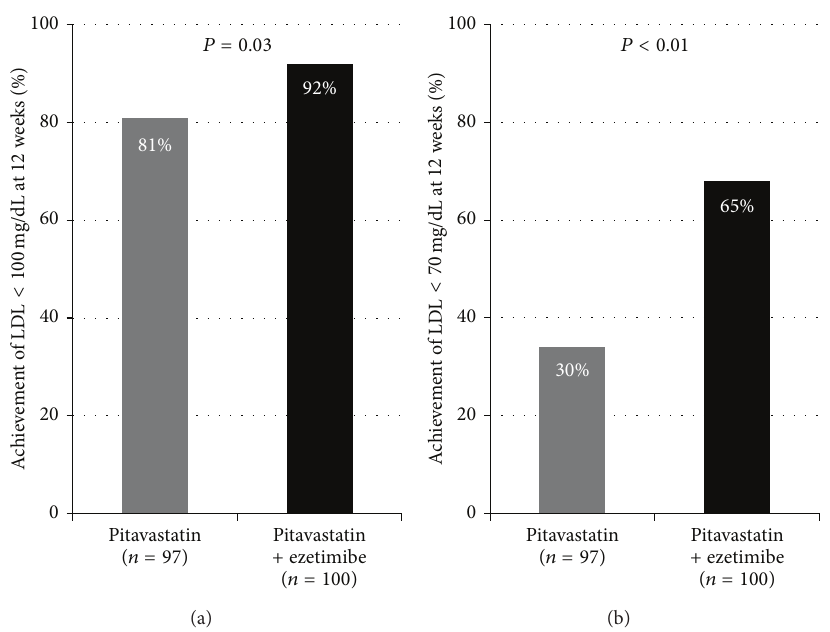
Figure 3: The achievement rate of LDL-C less than 100mg/dL is the recommended target of the Japan Atherosclerosis Society guidelines, and the achievement rate of LDL-C less than 70 mg/dL is the recommended target of Adult Treatment Panel III (ATPIII) and European Atherosclerosis Society (EAS) guidelines. In each analysis, the achievement rate is significantly higher in the pitavastatin + ezetimibe group than in the pitavastatin